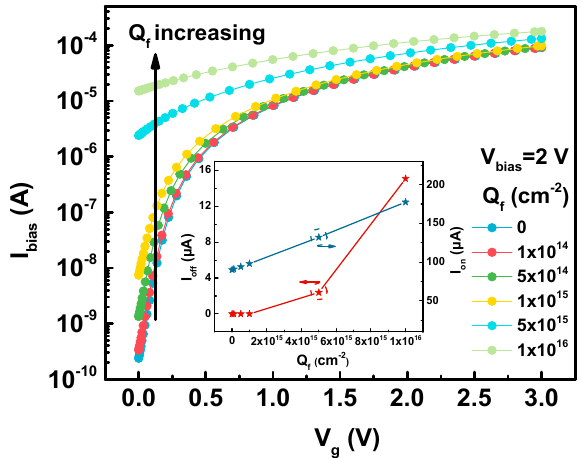
Figure 2. Simulation results of the I bias –V g curve of a FD-SOI Hall sensor with changes in the fixed charge density ( Q f ) in the oxide. The inset shows the variation of the leakage current ( I off ) and the on current ( I on ) with fixed charge density.